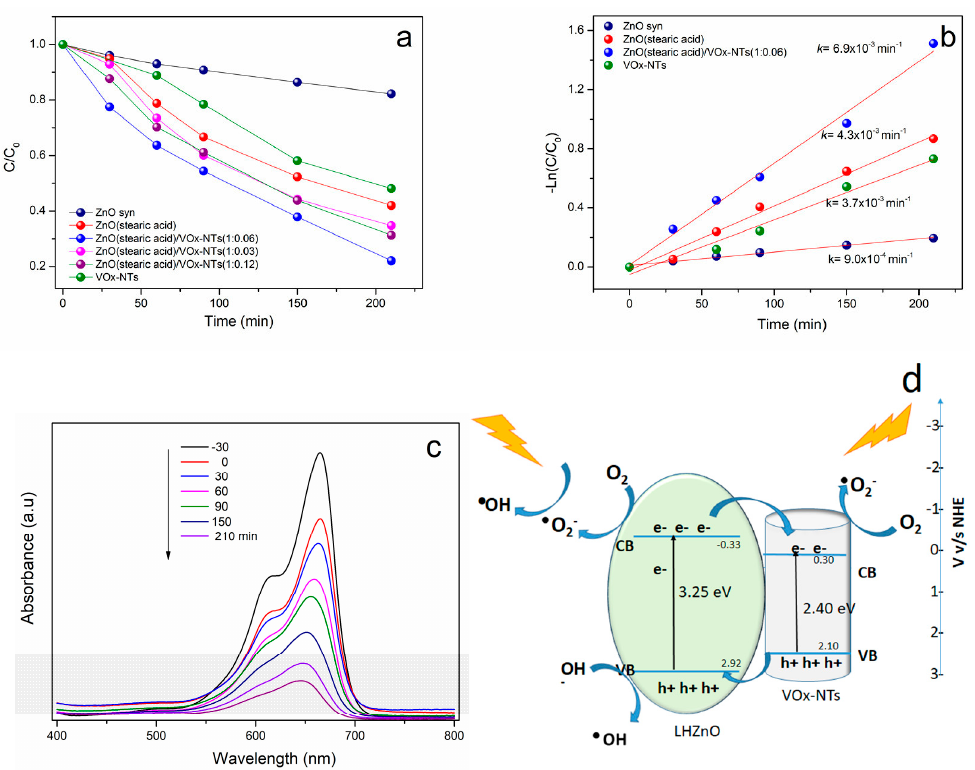
Figure 4. ( a ) Photocatalytic degradation of MB under visible light of samples, ( b ) photodegradation kinetics of MB over samples, ( c ) UV ‐ vis degradation of MB ZnO (stearic acid)/VOx ‐ NTs 1:0.06 and ( d ) schematic illustration of the photocatalytic mechanism of ZnO (stearic acid)/VOx ‐